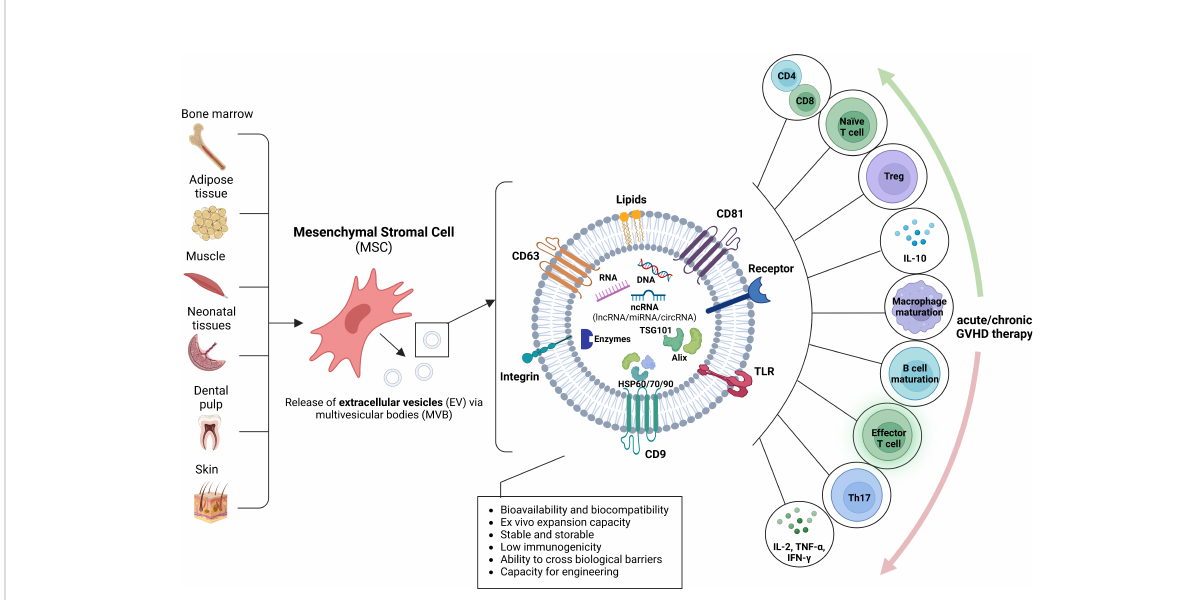
FIGURE 3 Origin of mesenchymal stromal cell extracellular vesicles and putative role for GVHD. Mesenchymal stromal cells (MSC) may be derived from a variety of sources, including bone marrow, adipose tissue, muscle, neonatal tissues, dental pulp and skin. The MSC release extracellular vesicles (EV) by inward budding of the plasma membrane and formation of intracellular multivesicular bodies (MVB), followed by exocytosis. MSC- derived EVs are enriched in various proteins with multiple functions, such as biogenesis-related proteins (e.g., TSG101, ALIX), common surface markers (e.g., CD9, CD81, CD29, CD44 and CD90), membrane transporter and fusion proteins (e.g., Rab GTPases and annexins), integrins, heat shock proteins (e.g., HSP60, HSP70 and HSP90) and MHC class I and II proteins, DNA, RNA and noncoding RNA (ncRNA), including miRNA, lncRNA, and circRNA. The MSC-EVs may modulate acute or chronic GVHD by acting on diverse immune